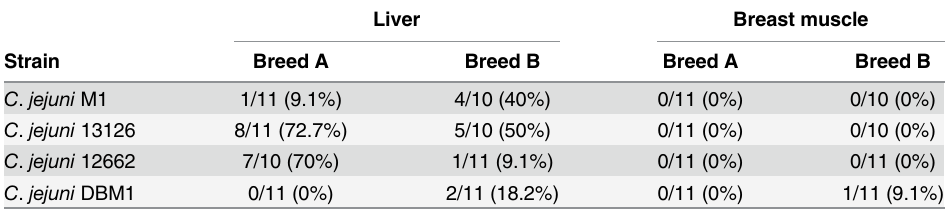
Table 3. Extra-intestinal spread of C . jejuni to edible tissues at 11 DPI. Liver Breast muscle Strain Breed A Breed B Breed A Breed B